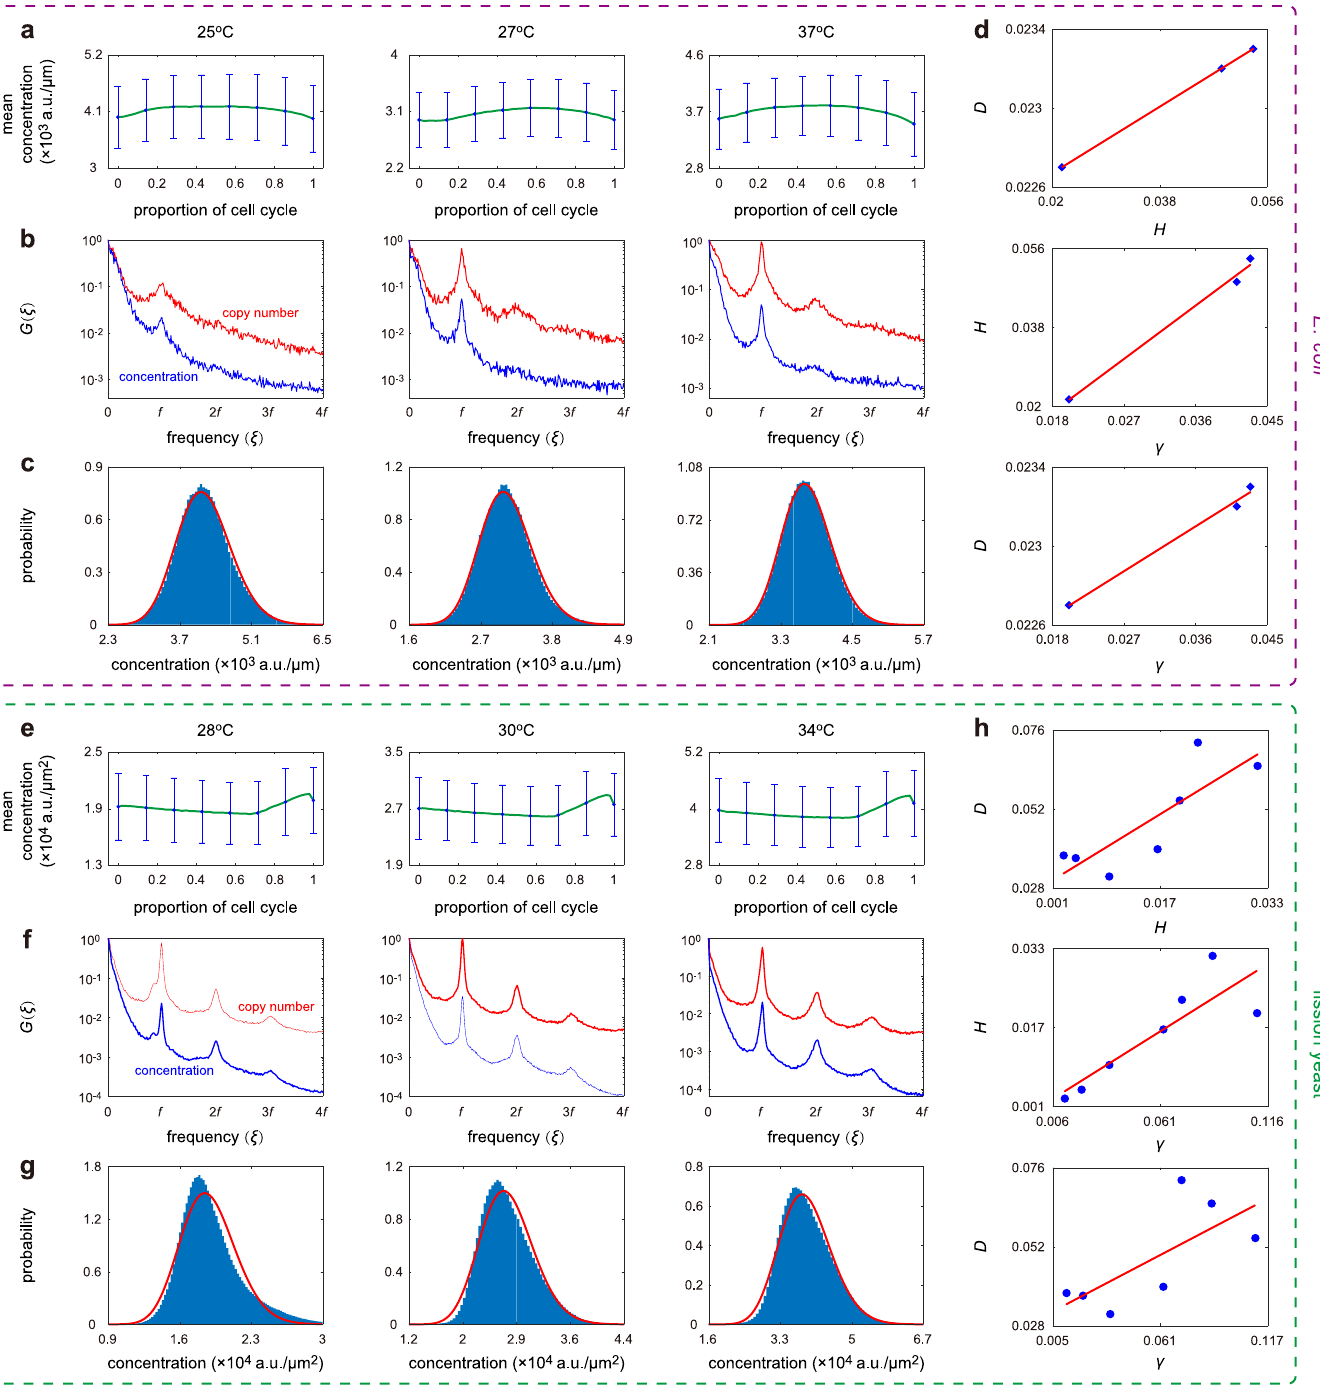
Fig 7. Analysis of single-cell lineage data of concentration fluctuations in E. coli and fission yeast. The data shown are published in [23, 96]. The E. coli data set contains the lineage measurements of both cell length and fluorescence intensity of a stable fluorescent protein at three different temperatures (25˚C, 27˚C, and 37˚C). The fission yeast data set contains the lineage measurements of both cell area and fluorescence intensity of a stable fluorescent protein under seven different growth conditions (Edinburgh minimal medium (EMM) at 28˚C, 30˚C, 32˚C, and 34˚C and yeast extract medium (YE) at 28˚C, 30˚C, and 34˚C). A : The change in the mean concentration across the cell cycle for E. coli under three growth conditions. Here, we divide each cell cycle into 50 pieces and compute the mean and standard deviation (see error bars) of all data points that fall into each piece. The CV squared of the mean concentrations of all pieces gives an estimate of ϕ ext and the CV squared of the concentrations of all cells gives an estimate of ϕ , from which γ can be inferred. B : Power spectra of copy number (red curve) and concentration (blue curve) fluctuations under three growth conditions. C : Experimental concentration distributions (blue bars) and their gamma approximations (red curve) under three growth conditions. D :